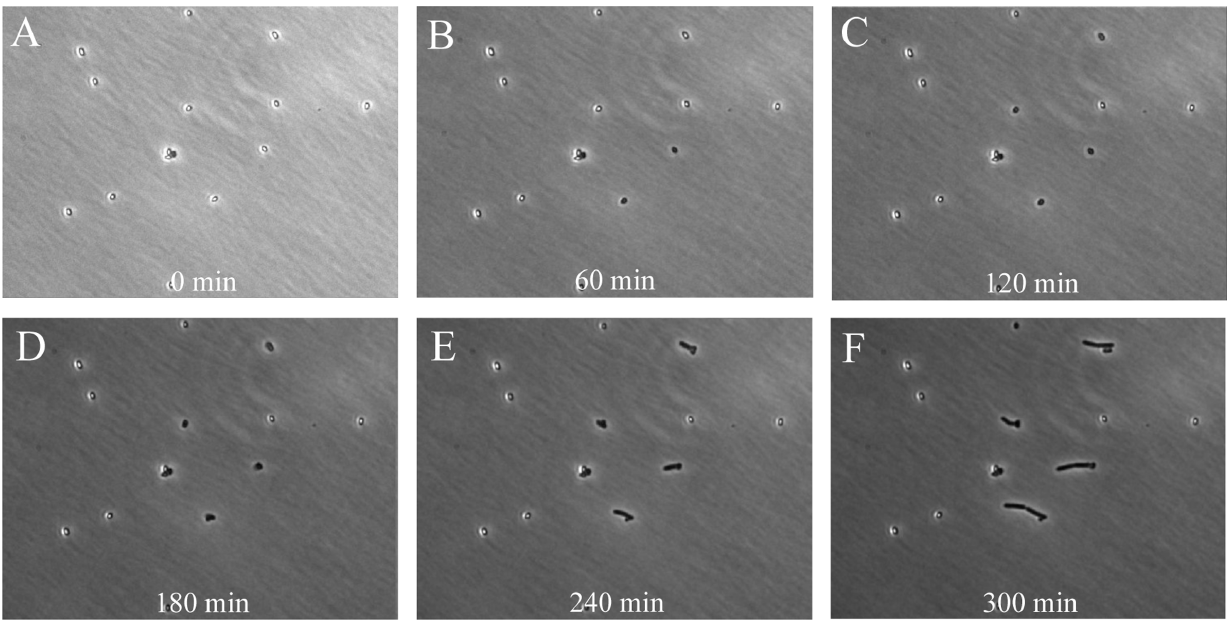
Figure 5. Time-resolved images of germination and outgrowth of heat-treated B.subtilis 1A700 spores. Heat-activated spores (70 u C for 30 min) were heat-treated for 10 min at 85 u C and spotted on 100% defined minimal (MOPS-buffered) medium including AGFK and followed in time using phase-contrast microscopy for 5 hours (Panels A till F ).